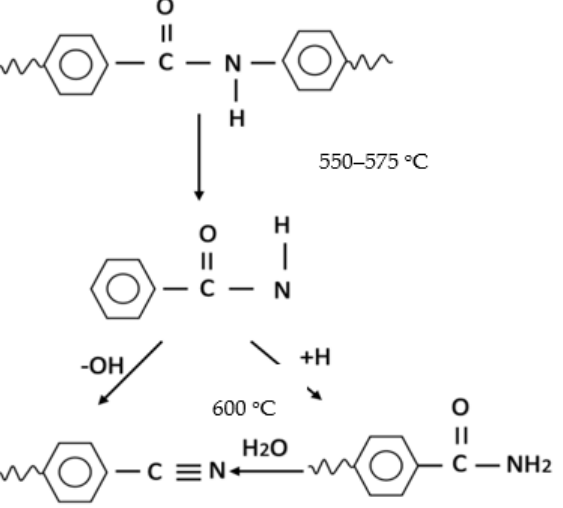
Figure 1. Representation of progressive decomposition process of the Kevlar structure [26].